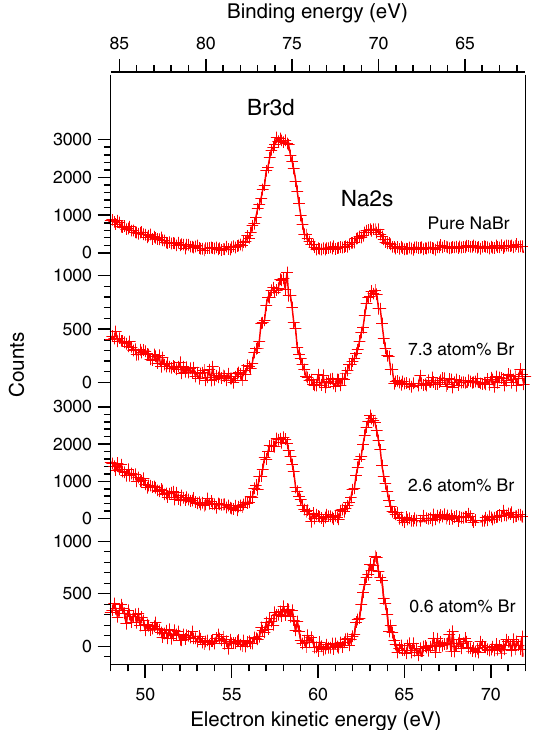
FIG. 2. Photoelectron spectra of mixed NaCl = NaBr solid aerosols generated from solution droplets with different NaCl = NaBr mixing ratios. The Br = Cl ion ratio in the solution is indicated for each spectrum. By using the Br 3d/Na 2s ratio in pure NaBr aerosols, the Br = Cl surface ratio in the mixed solid aerosols is inferred. The spectra have been recorded at a photon energy of 133.5 eV, which generates photoelectrons with kinetic energies lying at the minimum of the “ universal curve ” of the electron inelastic mean-free-path to ensure maximum surface sensitivity. The acquisition time for each spectrum is around two